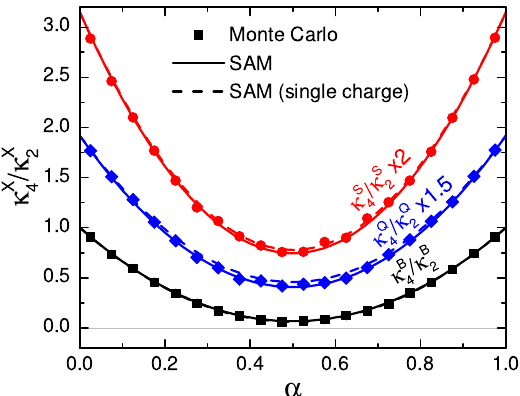
Figure 3 . Dependence of kurtosis cumulant ratios (cid:20) 4 =(cid:20) 2 of net-baryon (black), net-charge (blue), and net-strangeness (red) numbers on the acceptance fraction (cid:11) , as calculated in the hadron reso- nance gas model using the canonical ensemble Monte Carlo sampler with 10 8 events (symbols) and analytically in the framework of the subensemble acceptance method (solid lines). The dashed lines depict SAM calculations for a single conserved charge [eq. (3.4)]. The Monte Carlo sample is the same as in (cid:12)gure